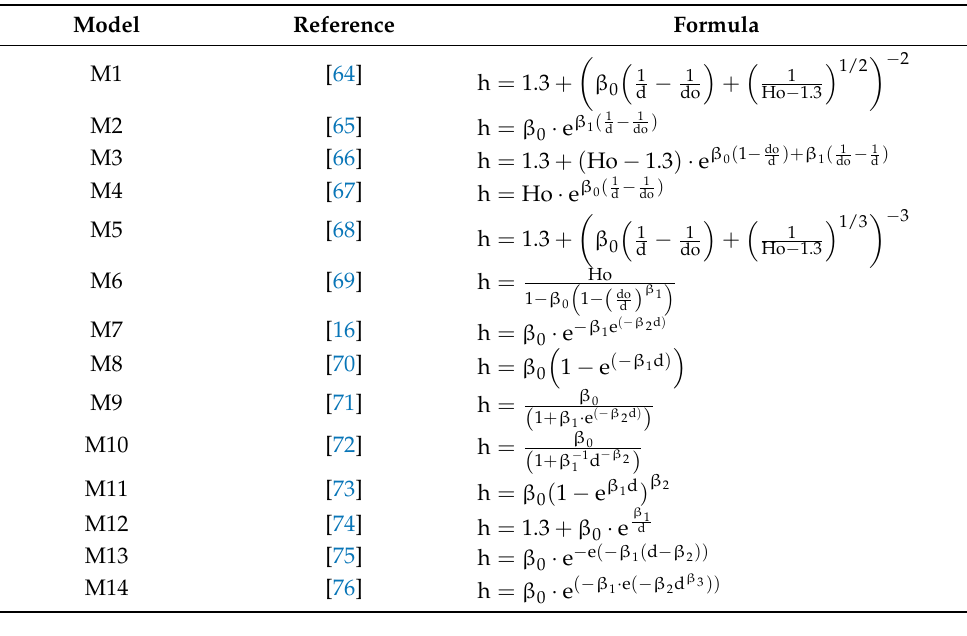
Table 1. Base tree Height–Diameter equations used in this study. h = total tree height; d: diameter at breast height; Ho = dominant height of the plot; do = dominant diameter of the plot, β 0 , β 1 , and β 2 : model